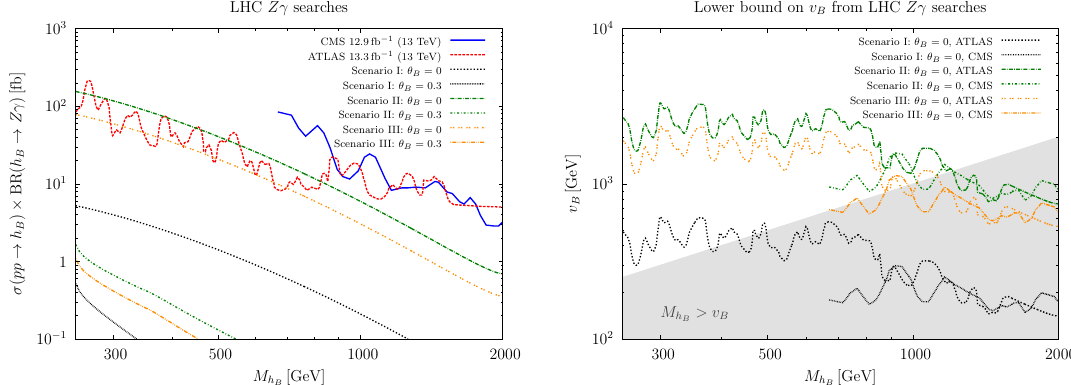
Figure 5 . Constraints from Z(cid:13) searches [28, 29]. Left panel: experimental bounds as well as cross section predictions in scenarios I, II, and II as a function of the baryonic Higgs mass. Cross sections are shown both for negligible mixing angle and for a near maximal value of (cid:18) B = 0 : 3. Right panel: experimental bounds translated into lower limits on v B as a function of M h negligible mixing. In the left panel we use v B = 2 TeV, and in both panels n f = 3 and m Q = 1